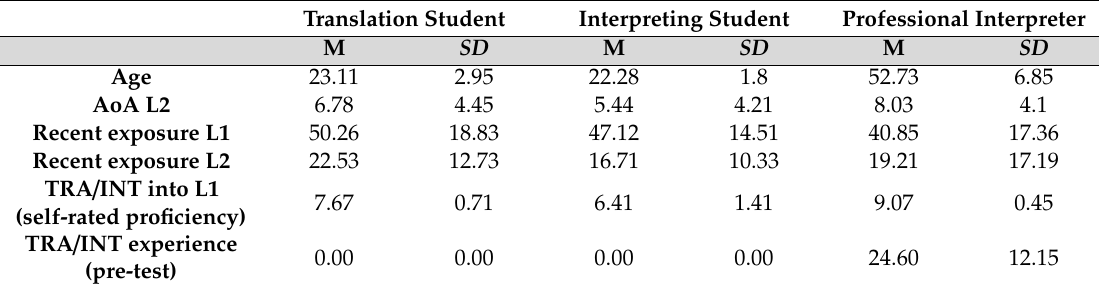
Table 1. Of participants’ language background characteristics.